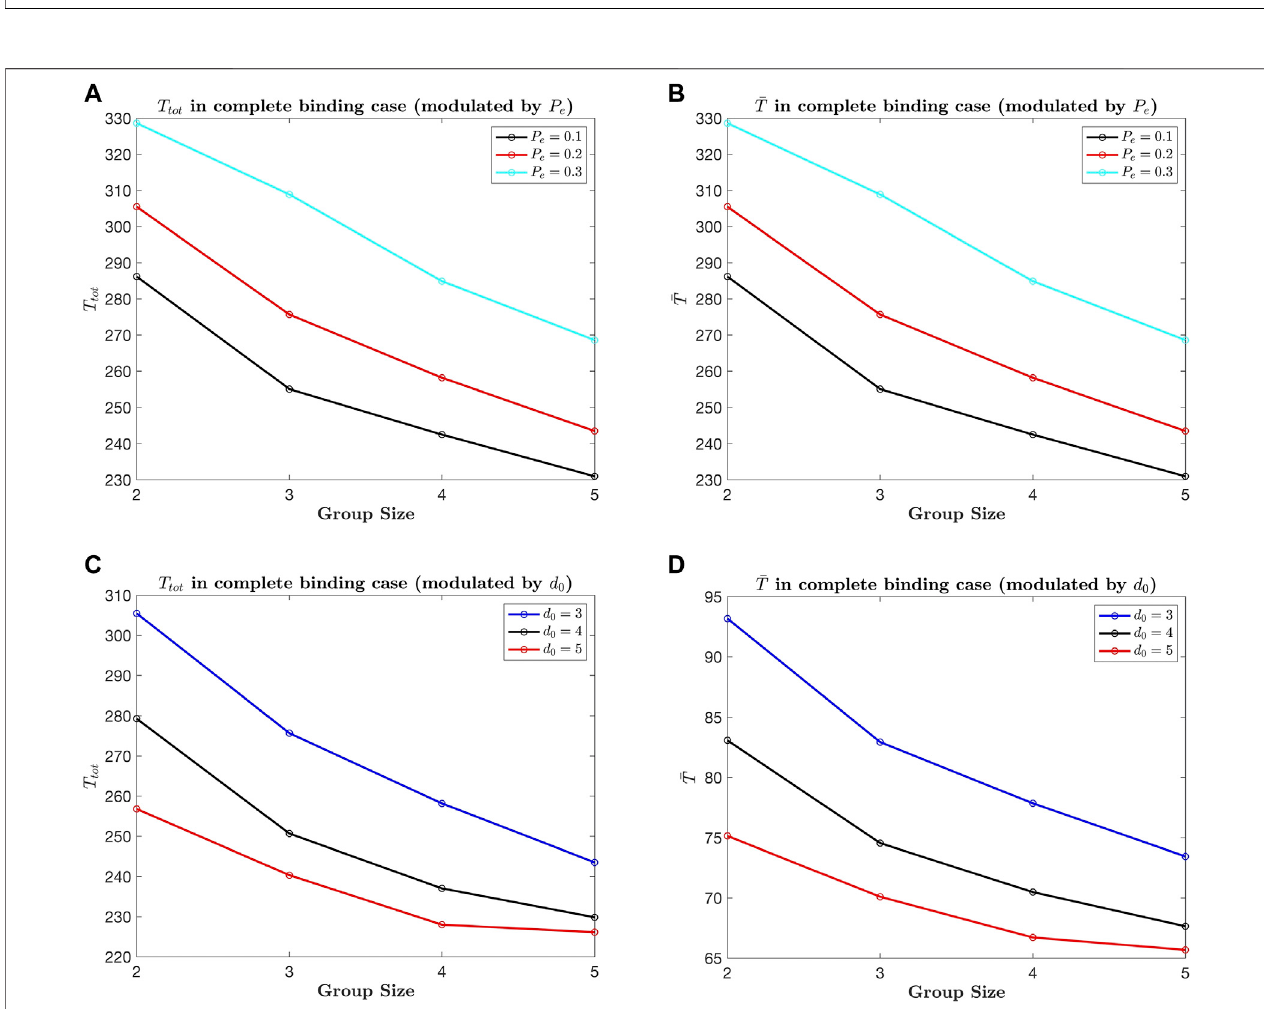
FIGURE 8 | Total and average evacuation time versus group size under different strengths (modulated by P e in (A,B) and by d 0 in (C,D) of complete binding.